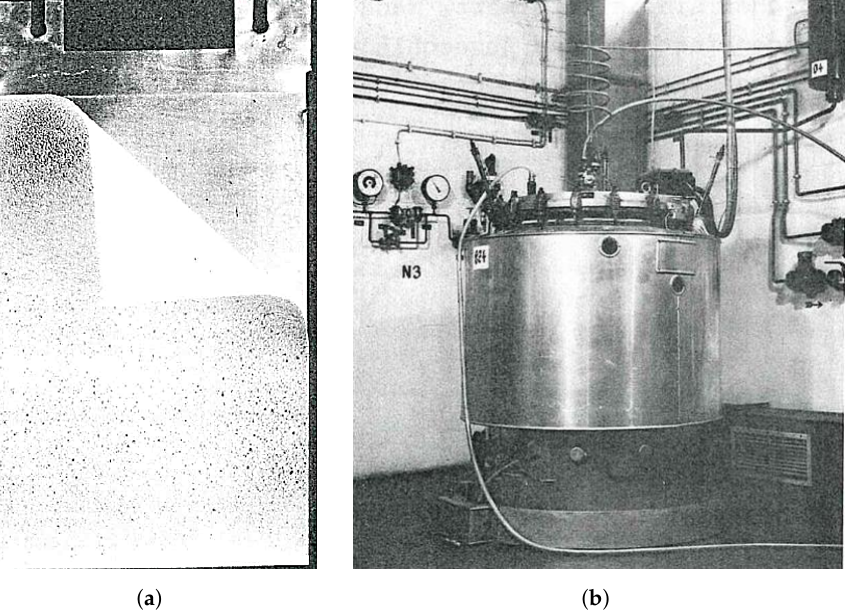
Figure 5. ( a ) High-purity refined aluminum deposited over cathode and ( b ) industrial-scale organic electrolysis cells at